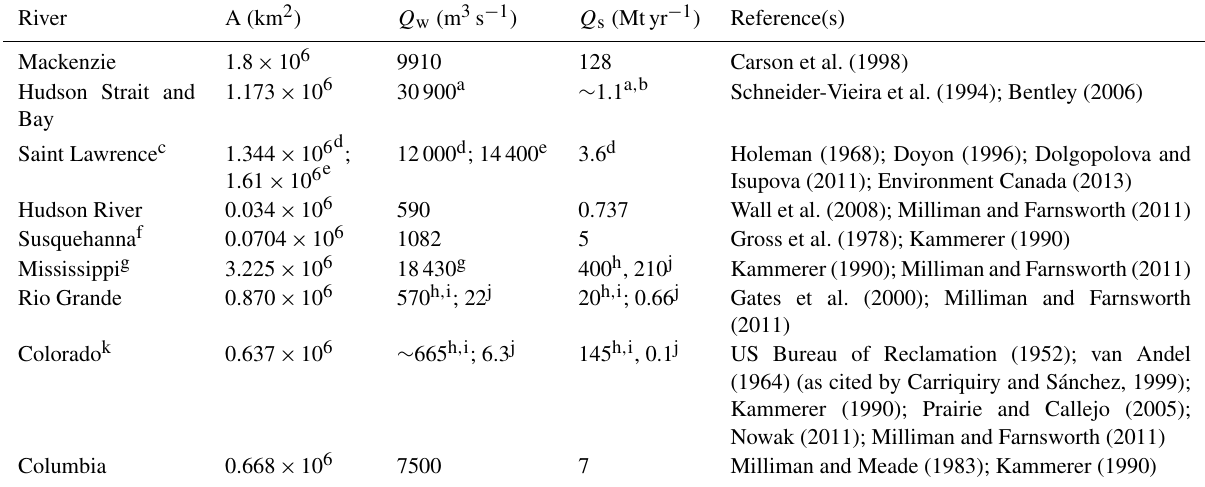
Table 1. Modern drainage basin areas and water ( Q w ) (cubic meters per second) and sediment ( Q s ) (10 6 metric tons per year) discharges. Many of these were gathered and independently of the Milliman and Farnsworth (2011) compilation, and generally provide good agreement with their